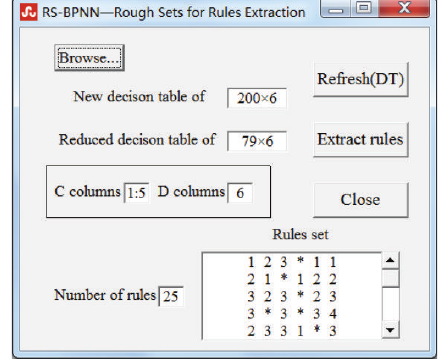
Figure 6: Rules extraction.